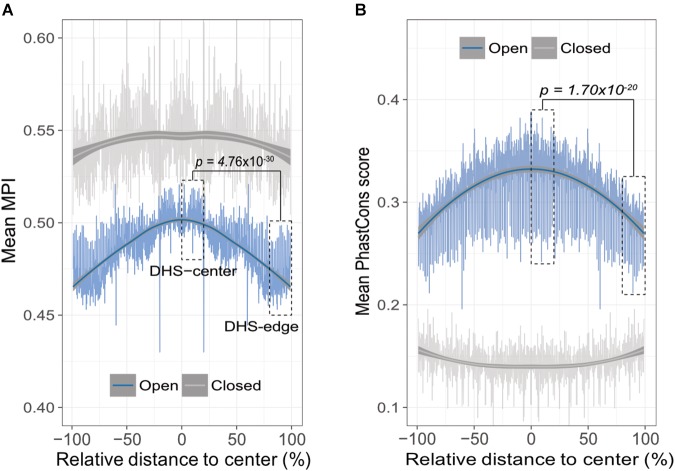
Edges of open-chromatin regions preferentially for the emergence of divergent TF binding motifs. (A) Distribution of mean MPIs at different relative positions within chromatin regions of 150–400 bp. Since DHS regions differ with respect to the lengths of their peaks, the mean MPI distribution for DHSs was calculated in 0.1% relative-distance sliding windows. The relative distance was defined as the normalized distance from the center of the fragments, ranging from 0% at the center to 100% at the edge of a given DHS peak. The mean MPI scores mirror each other around the center of the DHS regions. DHS-center denotes the quintile regions in the center of a DHS, and DHS-edge denotes the decile regions in both DHS borders. “Open” denotes the DHS regions and “closed” denotes the promoter regions without overlapping with DHSs. (B) Distribution of the mean PhastCons conservation scores at various relative positions within open- and closed-chromatin regions of 150–400 bp. P-values in (A) and (B) for comparisons between the DHS-center and -edge regions were obtained using one-sided Wilcoxon rank-sum tests.